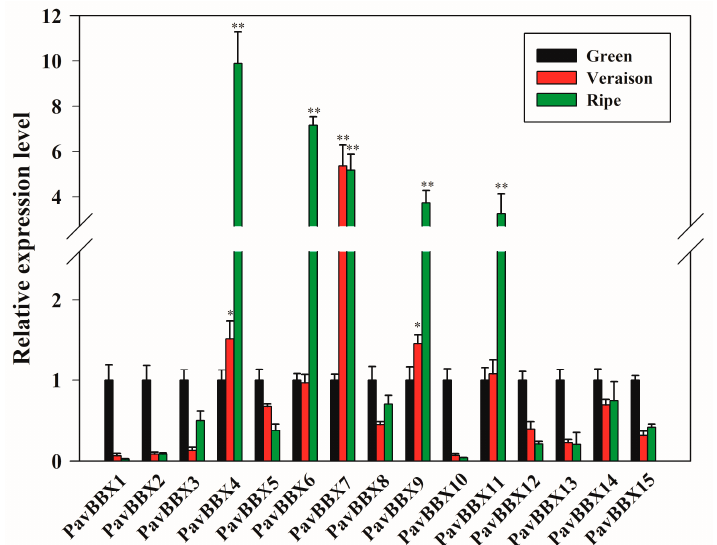
Figure 4. Expression profiles of the sweet cherry PavBBX genes during three stages of fruit development. PavActin was used as the internal reference control to normalize template levels. The relative mRNA levels are represented as the mean ± SD (n = 3). Statistically significant differences were assessed using Student’s t -test (* p < 0.05, ** p < 0.01).